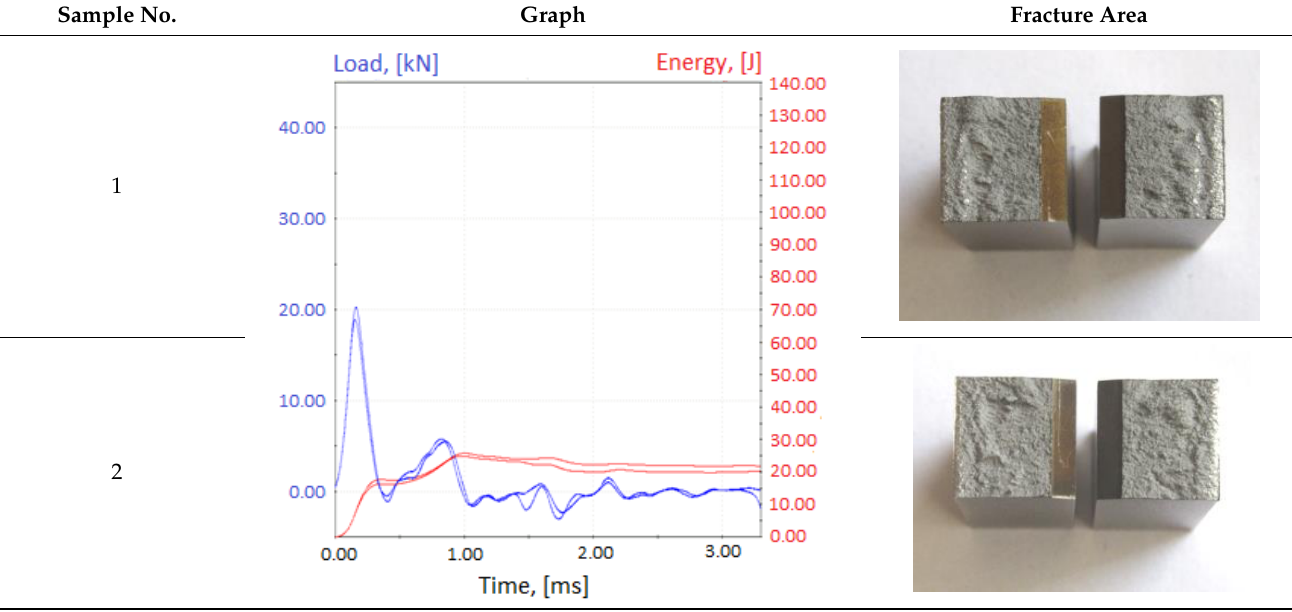
Table 2. Test results — Fracture pictures and graphs of exerted energy and load (as delivered material). Sample No.